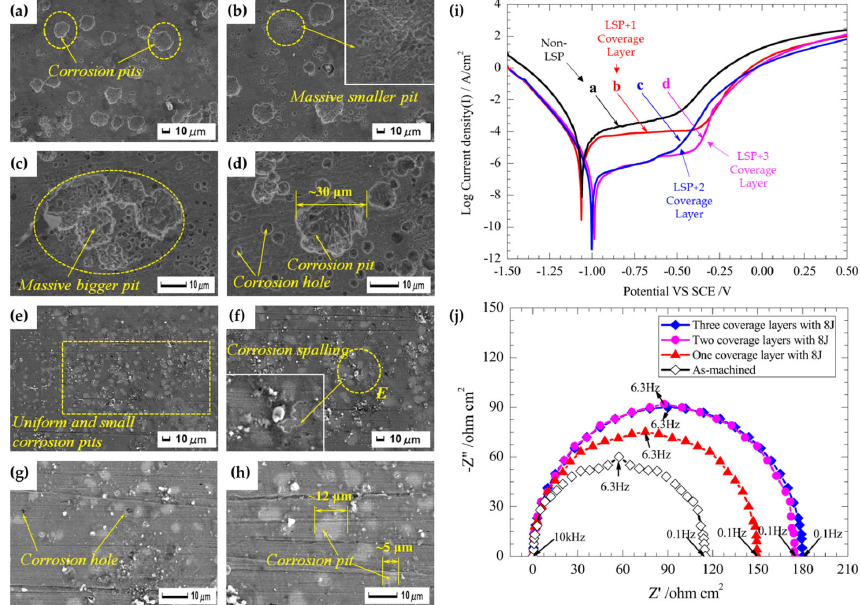
Figure 12. The corrosion pit morphology of high-temperature-immersed ( a – d ) AISI 4145 medium carbon steel and ( e – h ) its LSP counterpart at 200 h. Additionally, their electrochemical characteristics under ( i ) PDP and ( j ) EIS conditions (displaying a Nyquist plot) [112].